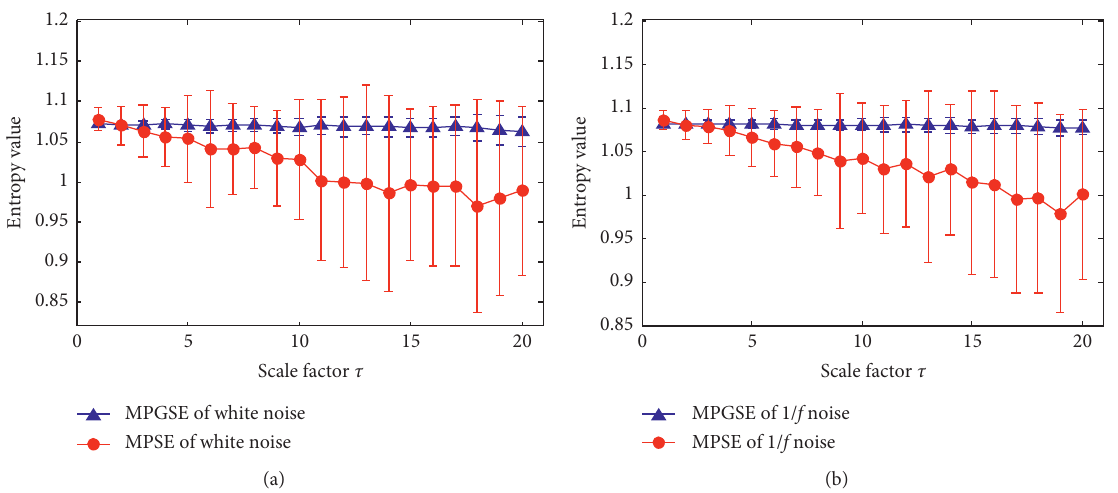
Figure 9: (a) MPGSE and MPSE curves of white noise and (b) MPGSE and MPSE curves of 1/ f noise.